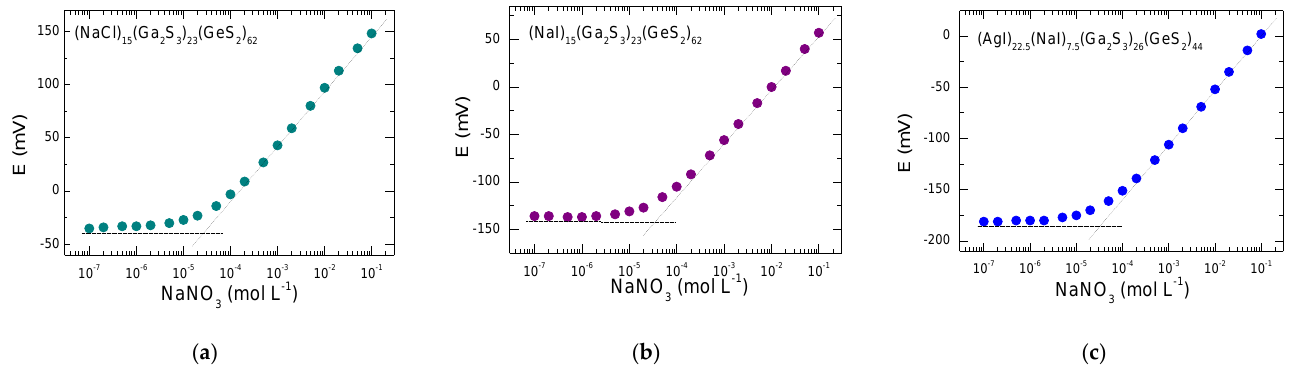
Figure 7. Typical calibration curves for Na + sensors based on ( a ) (NaCl) 15 (Ga 2 S 3 ) 23 (GeS 2 ) 62 , ( b ) (NaI) 15 (Ga 2 S 3 ) 23 (GeS 2 ) 62 and ( c ) (AgI) 22.5 (NaI) 7.5 (Ga 2 S 3 ) 26 (GeS 2 ) 44 glass membranes.